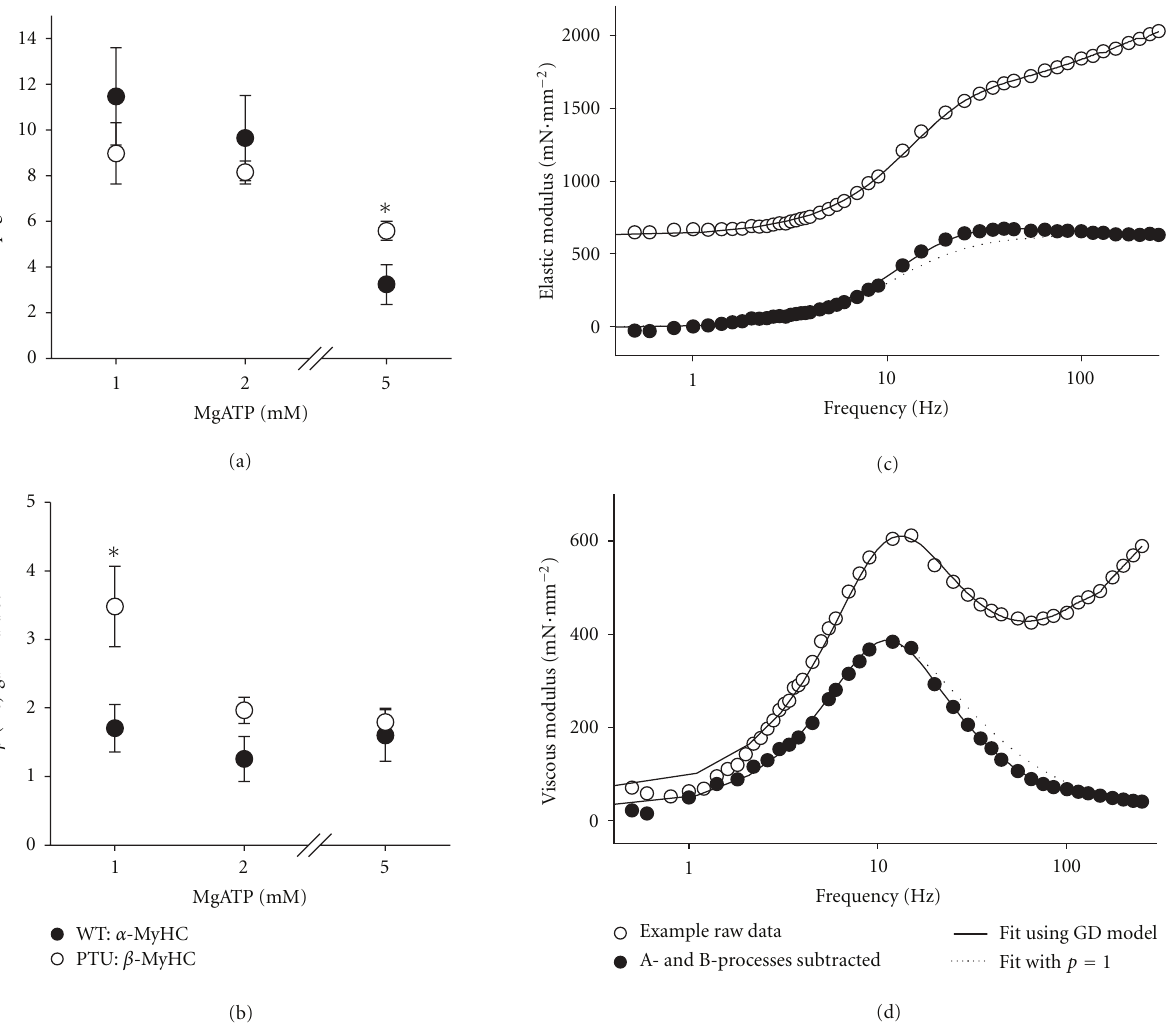
Figure 6: Results of fitting elastic and viscous modulus to gamma distributed and single exponential distributed models of PDF t b) The shape parameter, p , and the scale parameter, β , were estimated from fitting the gamma distribution model of (16) to the measured elastic and viscous moduli. ∗ P < 0.05 by t -test between MyHC isoforms at same MgATP. (c) The elastic modulus recorded from one PTU β -MyHC muscle preparation at 1mM MgATP is shown with its fit to (16), that is, the gamma distribution (GD) model. The goodness of fit is representative of the fits for all samples in this study. The A- and B-processes of (16) were then subtracted from the recorded elastic modulus to demonstrate fluctuations in the remaining C-process, which are more apparent when compared against the single exponential model ( p = 1) of the t att distribution (dotted line). These fluctuations are mechanical consequences of the gamma distributed t att . (d) The corresponding viscous modulus was also subjected to fit and subtraction of A- and B-processes. The resulting C-process is compared against the single exponential model of the t att distribution (dotted line). The asymmetry in the peak of the viscous modulus is subtle, but apparent at frequencies higher than